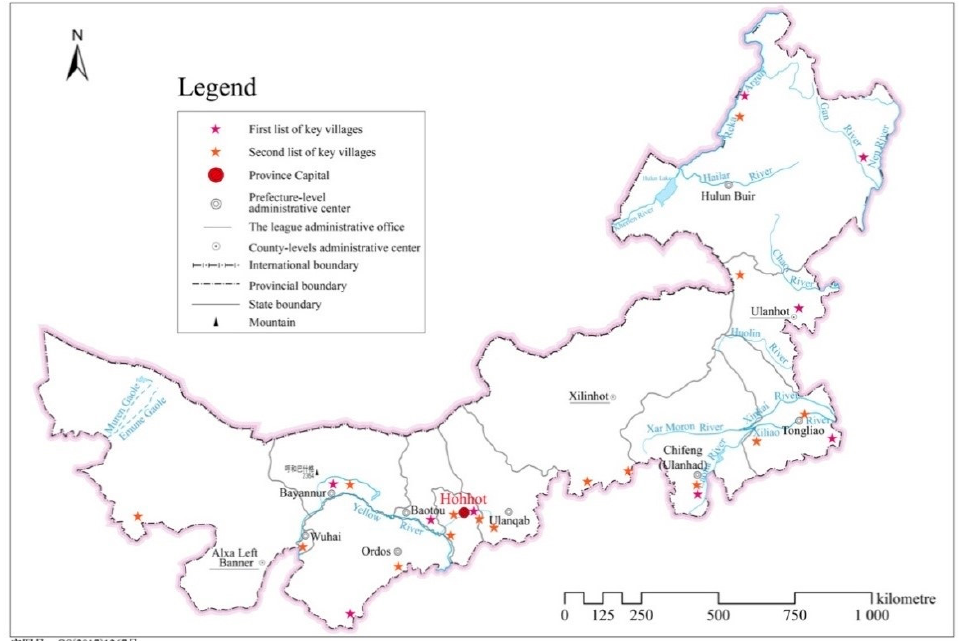
Figure 1. Rural tourism key villages in Inner Mongolia in 2020. Note: This drawing is based on the standard map obtained from the standard map service system of the Ministry of Natural Resources of the People’s Republic of China (drawing review No.: GS (2017) No.1267). The base map has not been modified. Table 1. Tourist reception and Income of tourism in Inner Mongolia.